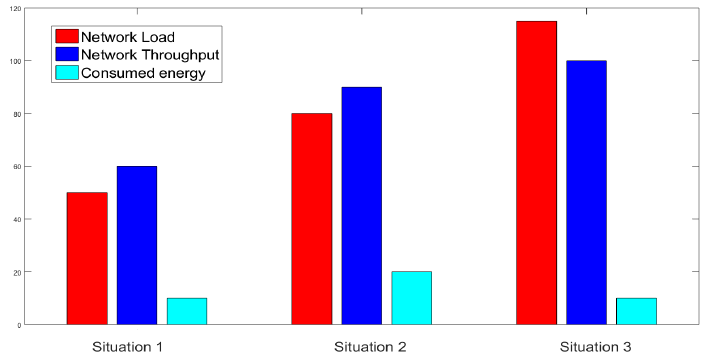
Figure 9. NS2 Simulation in Stage